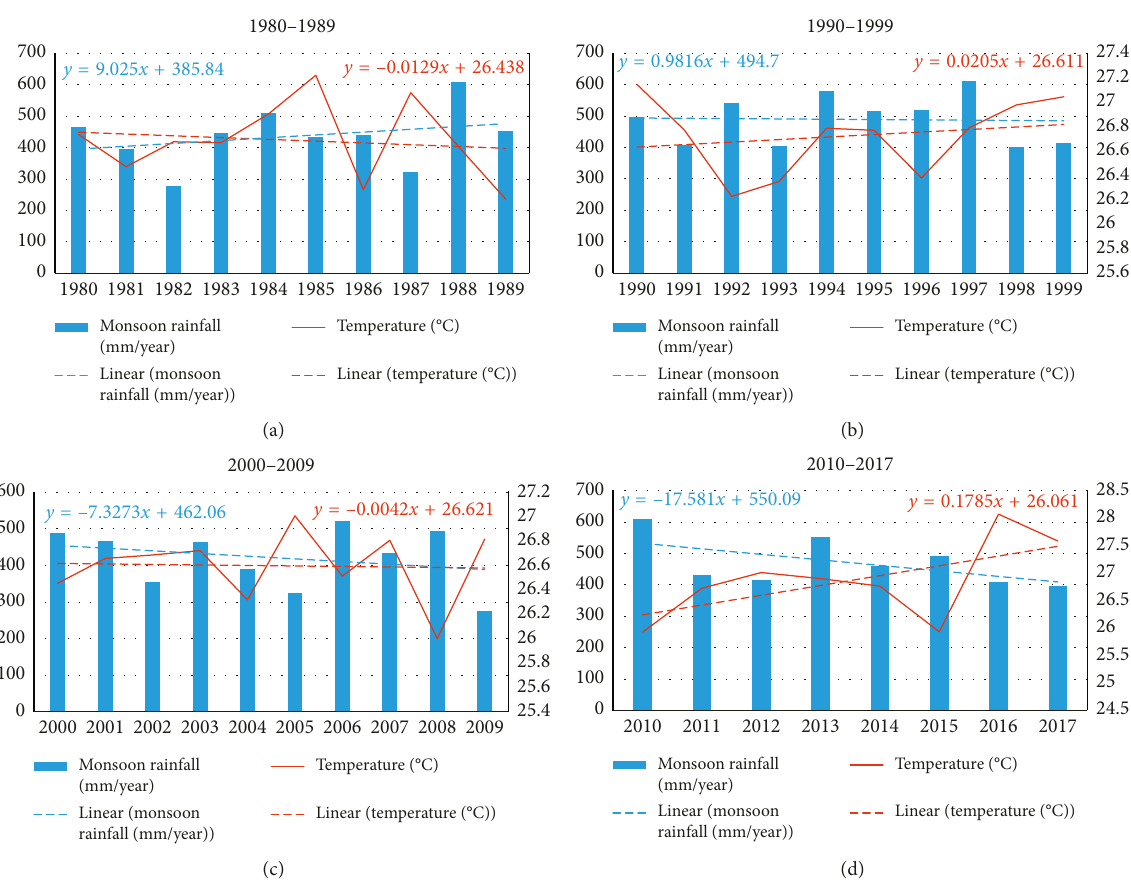
Figure 5: Decadal variations of total rainfall and seasonal mean temperature during monsoon season in Pakistan; all the time series after 1990 have shown a decrease in monsoon precipitation, the decrease being the sharpest in the last eight years. Increase in temperature is steepest in the last 8 years as well while 1980–1989 and 2000–2009 showed a slight decrease in temperature.